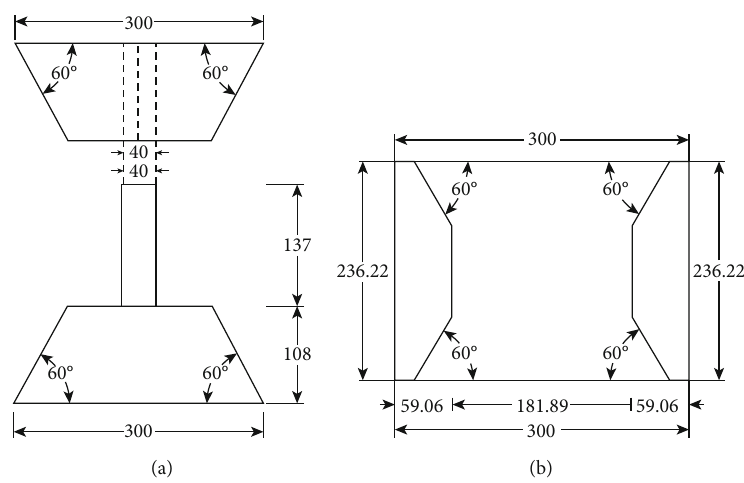
Figure 9: Speci fi c size of the auxiliary expansion device: (a) front view and (b) top view.